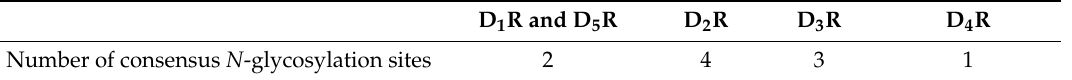
Table 2. NH 2 terminal tail in D1-like and D2-like receptors.